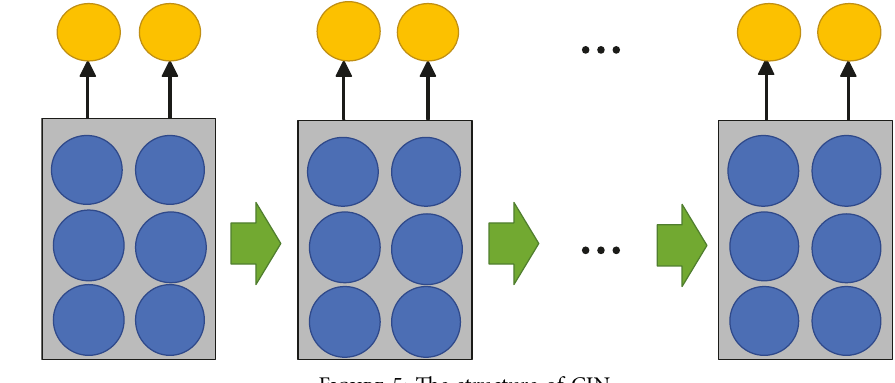
Figure 5: The structure of